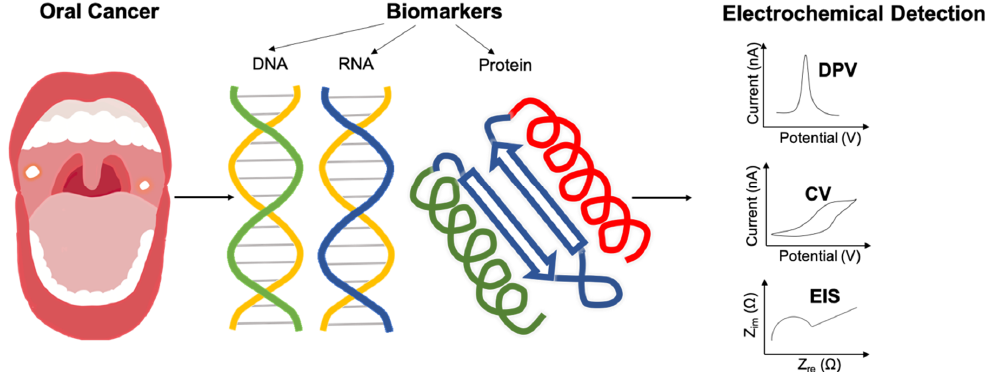
Figure 1. Schematic illustration of an oral cancer-detecting process by using